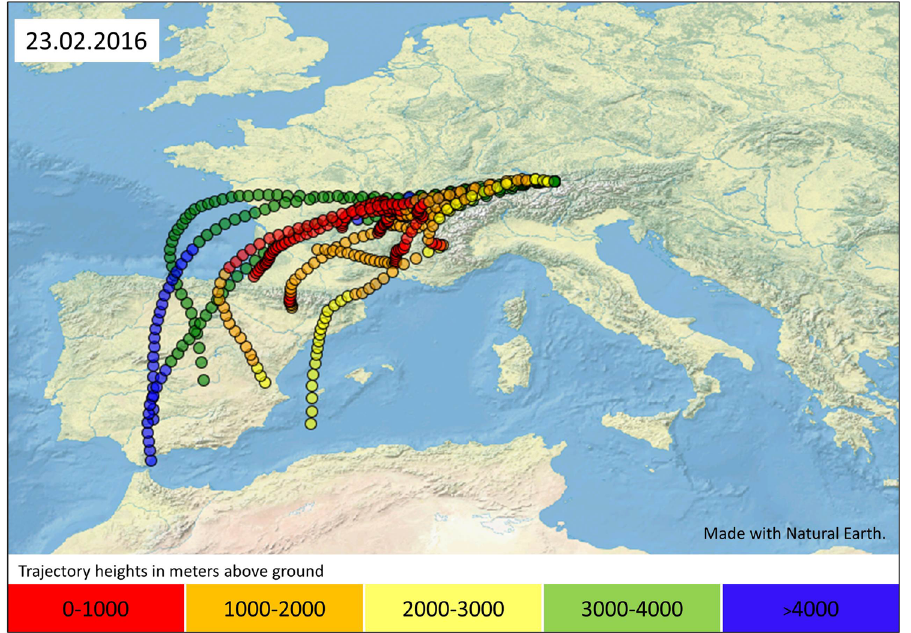
Figure 4. Backward trajectories arriving at Umweltforschungsstation Schneefernerhaus on the 23.02.2016 between 0 and 10 am, computed using the FLEXTRA code. Meteorological driver is the Global Forecast Model. Made with Natural Earth 62